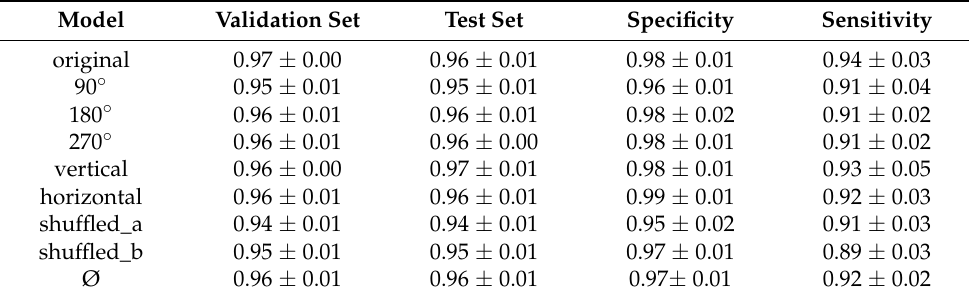
Table 4. Accuracy for the validation and test sets of all models at the genus level.